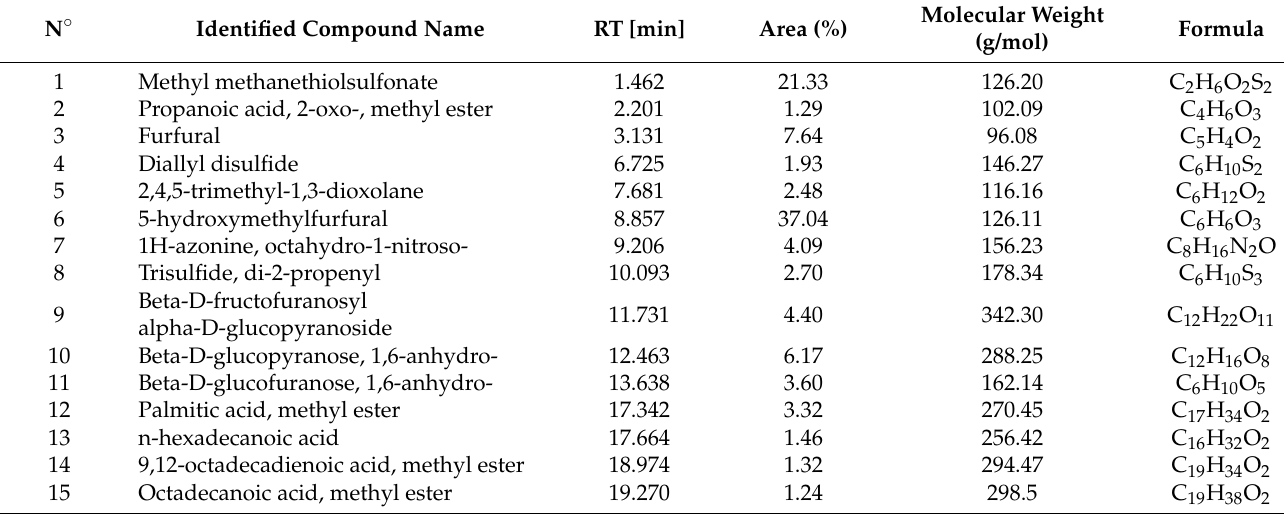
Table 1. Phytochemical composition of aqueous extract of A. subhirsutum L. (bulbs) using the GC–MS